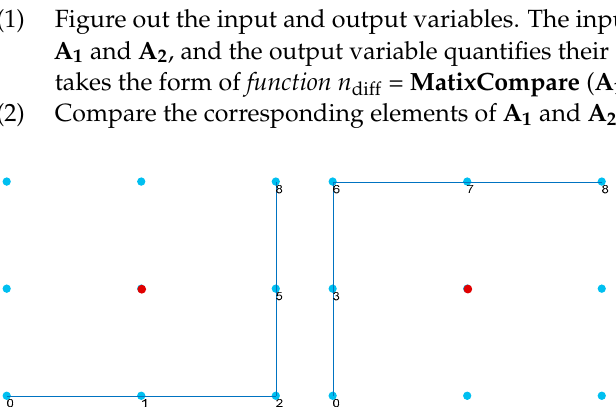
Figure 10. Two paths between Node 8 and Node 0 with Node 4 removed.